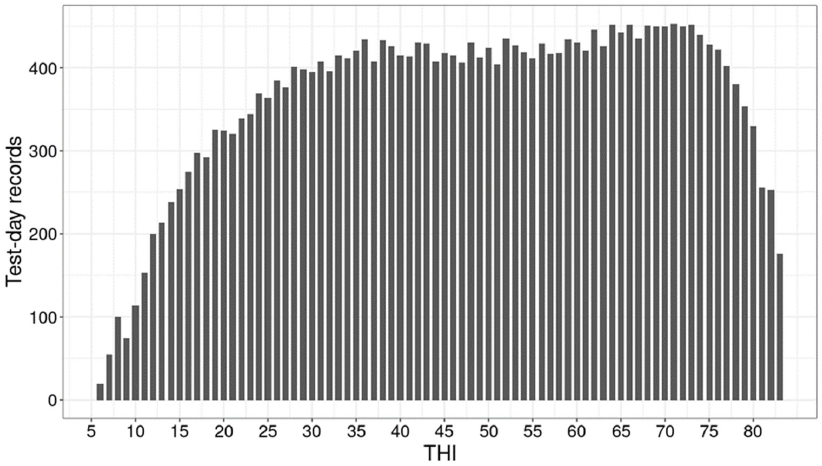
Figure 2. Number of test-day records per temperature-humidity index (THI).